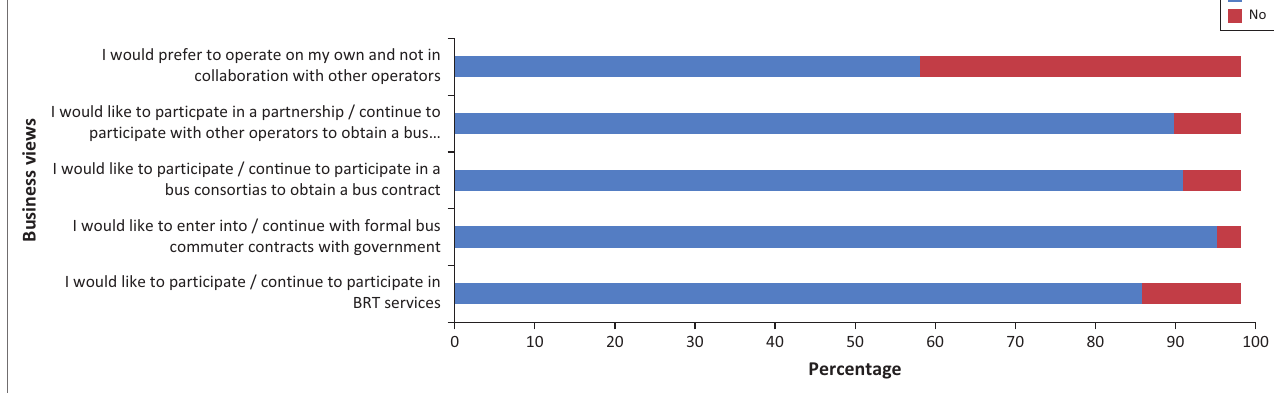
FIGURE 8: Future business views.